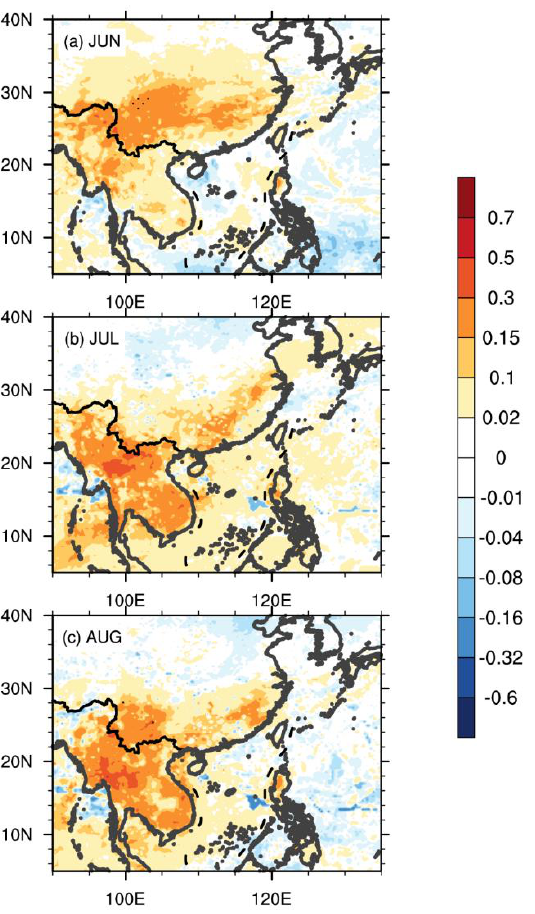
Figure 8. Monthly average difference in aerosol optical depth (AOD, 550 nm) due to ADE (CTL-SEN test) on ( a ) June, ( b ) July, and ( c ) August.